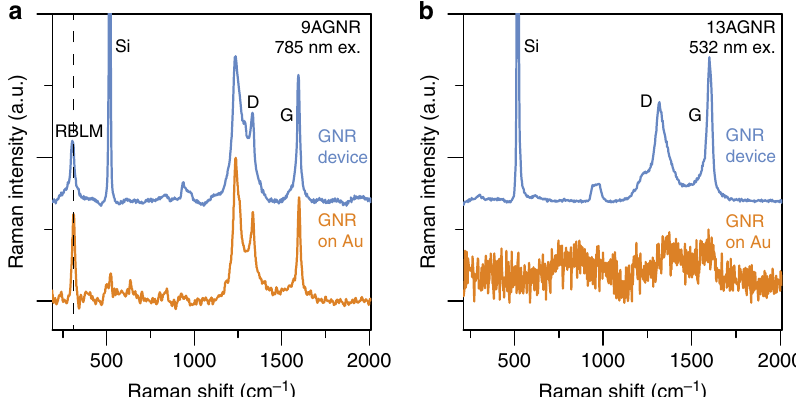
Fig. 2 Raman spectra of as-grown GNRs on Au and GNRs after transfer and device processing. Raman spectra of a 9AGNRs and b 13AGNRs on the Au(111) growth substrate and after device fabrication shows that the GNRs remain intact. Since the excitation is off-resonance with the 13AGNR absorption, the Raman signal is weak on Au and the RBLM is not